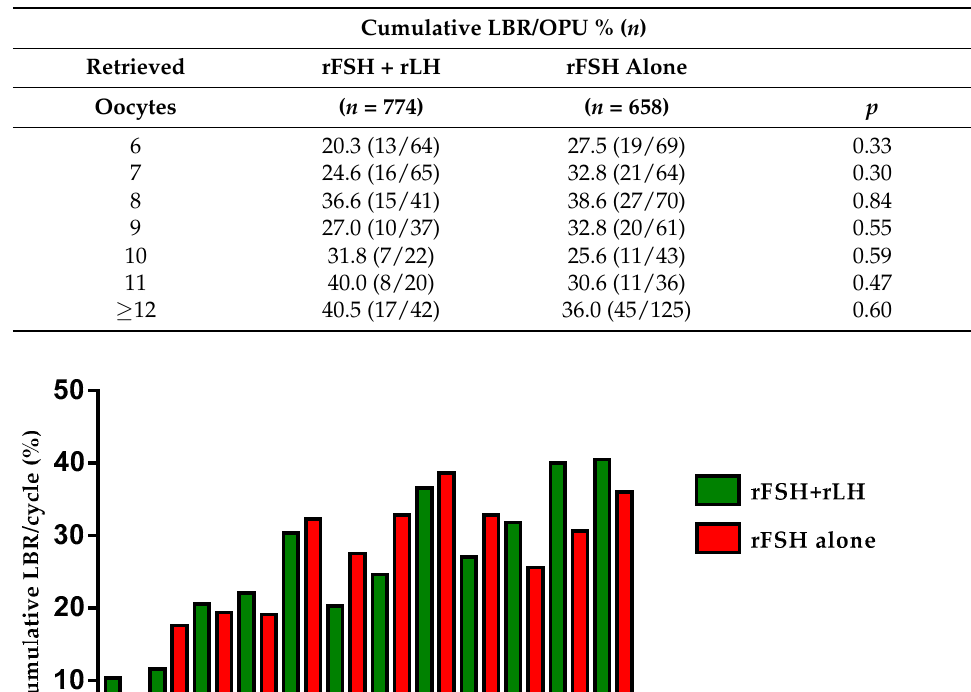
0.95 Table 3. Cumulative live birth rates of all patients with available oocytes ( n = 1432) receiving COS with rFSH + rLH ( n = 774) or rFSH alone ( n = 658), stratified for to the number of retrieved oocytes at OPU. Data are expressed as absolute values and percentage.